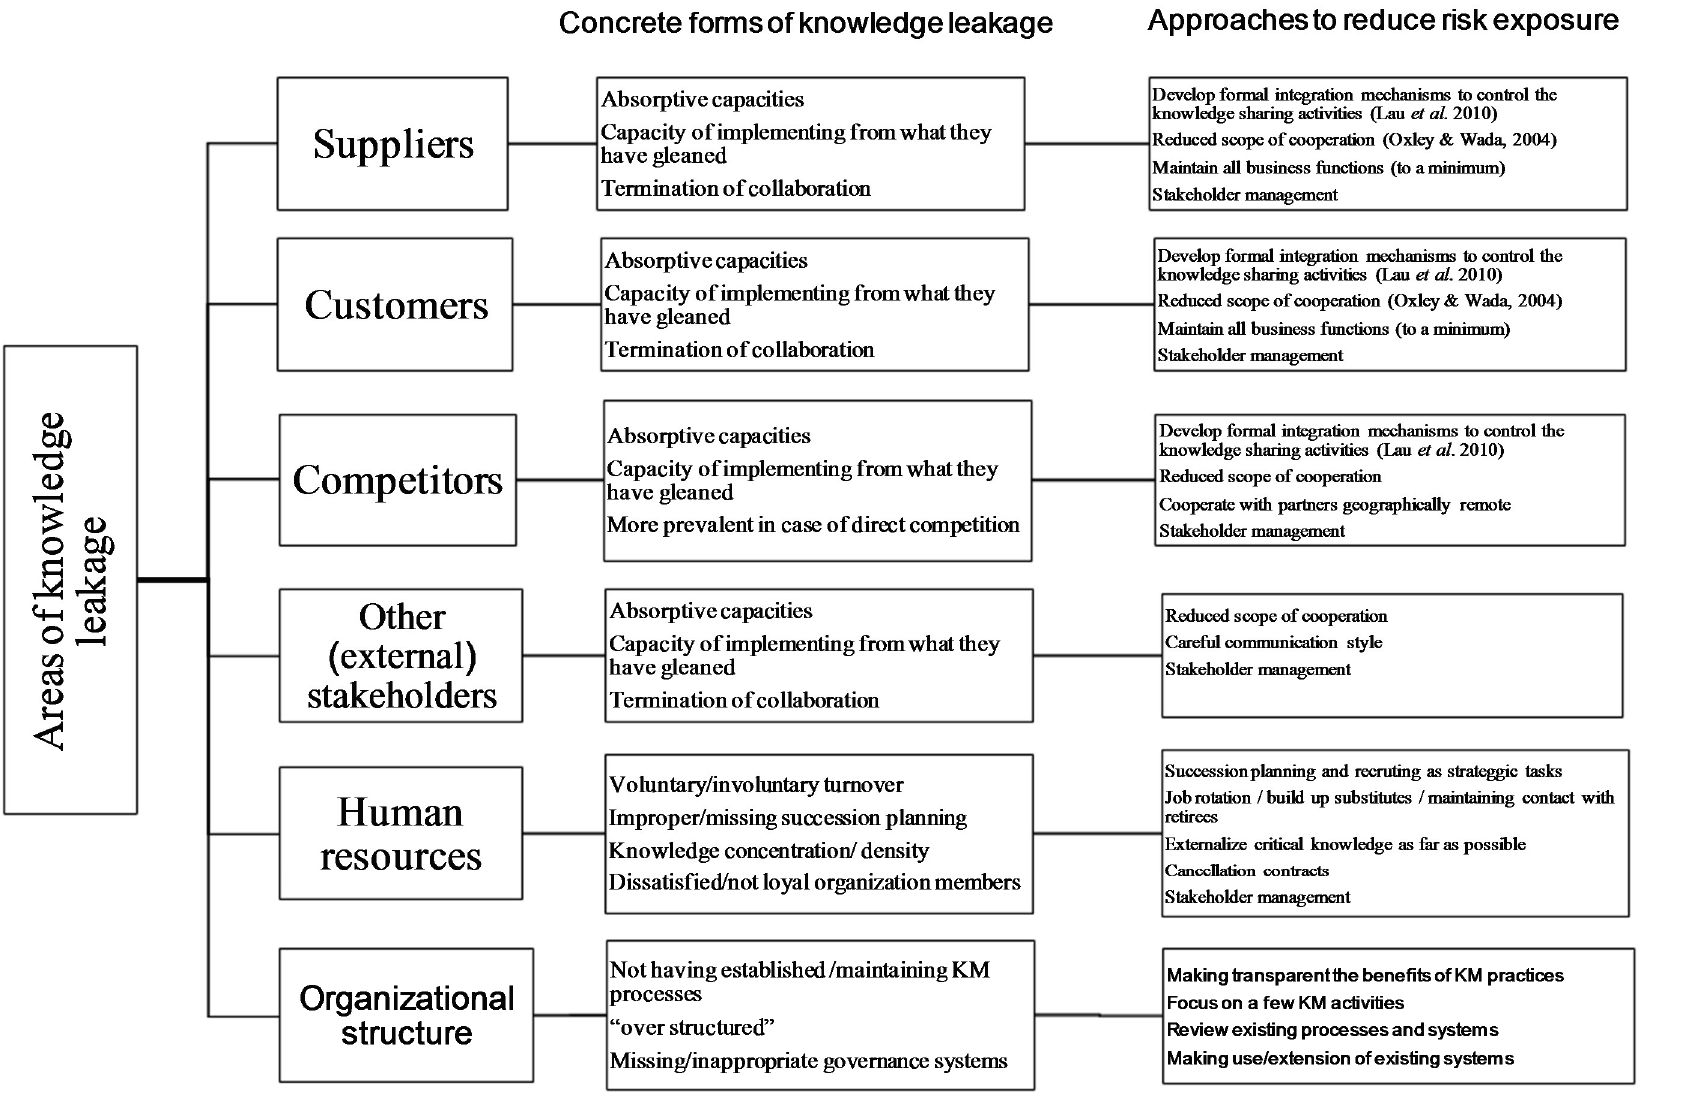
Figure 1. Framework for addressing knowledge leakages in small and medium-sized